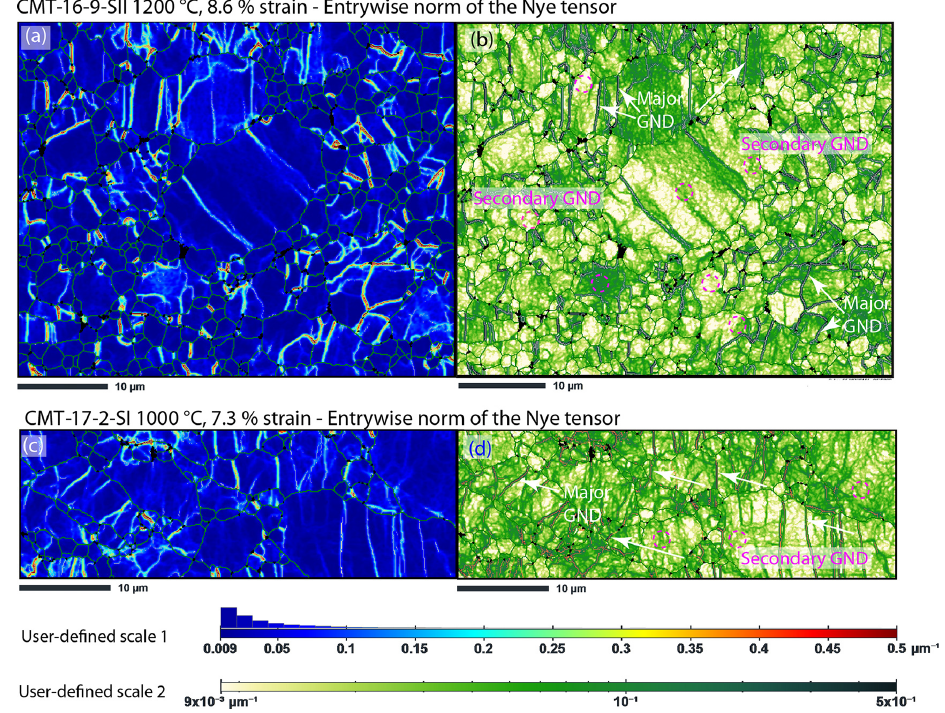
Figure 11. Representative distribution of the different entrywise norm of GND (major and minor type; see main text for details) with two different display strategy: (a) and (b) from a sample deformed in compression at high temperature and low stress (CMT-16-9) and (c) and (d) at low temperature and high stress (CMT-17-2). In (a) and (c) , the classic jet color scale was used with a linear user-defined scale and a smoothing factor of 2; in (b) and (d) the linear-green color scale was used with a user-defined log scale and a smoothing factor of 1. The acquisition step size is